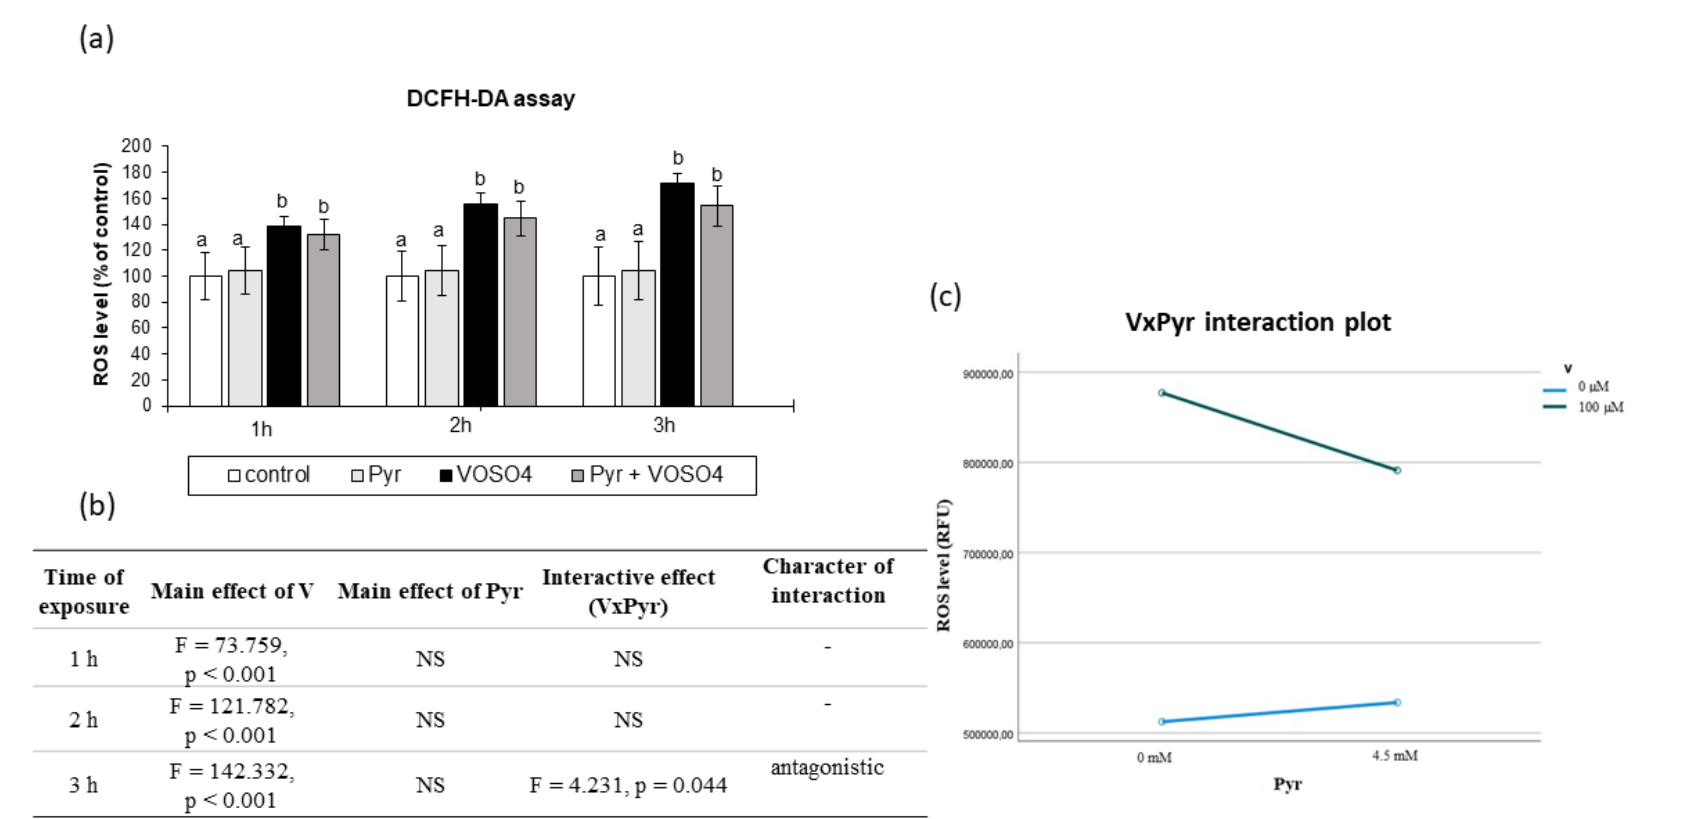
Figure 2. Effects of vanadium and/or pyruvate on ROS accumulation in CHO-K1 cells detected by the DCFHDA assay. The H2DCFDA-preloaded cells were incubated in DMEM/F12 medium without (control) or with 100 μM VOSO 4 in the presence or absence of sodium pyruvate (Pyr) (4.5 mM) for 1, 2 and 3 h. ( a ) Intracellular accumulation of ROS on the basis of DCF fluorescence emissions expressed in percentage. Data represent the mean ± SD of quadruplicate determinations of three distinct experiments. Means at the same time point followed by a common letter are not significantly different. Data were analysed by one-way ANOVA followed by Tukey’s post hoc test ( b ) Results of the two-way ANOVA analysis of DCF fluorescence emissions after 1-, 2-, and 3-h exposure to V (as VOSO 4 ) and Pyr (pyruvate); NS: no significant effect. ( c ) Interaction graph illustrating antagonistic interaction between V and Pyr for the intracellular ROS level after 3-h incubation.